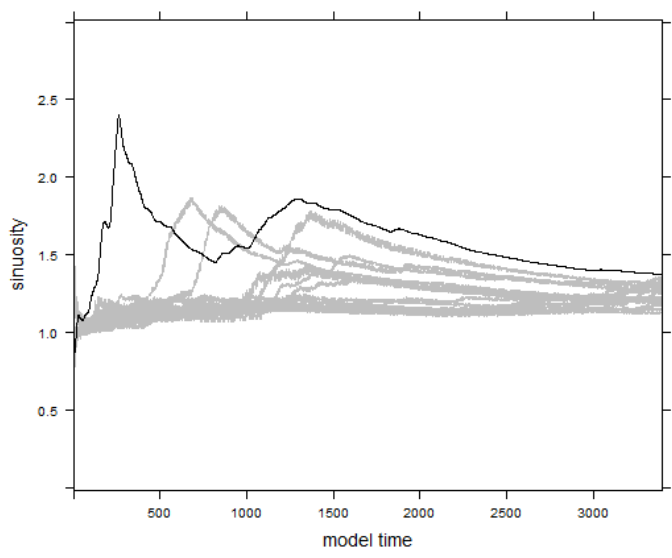
Figure 8. Variation of sinuosity of flight paths of homing pigeons as observed in the empirical data (black) and as simulated using optimized flight parameters (grey).